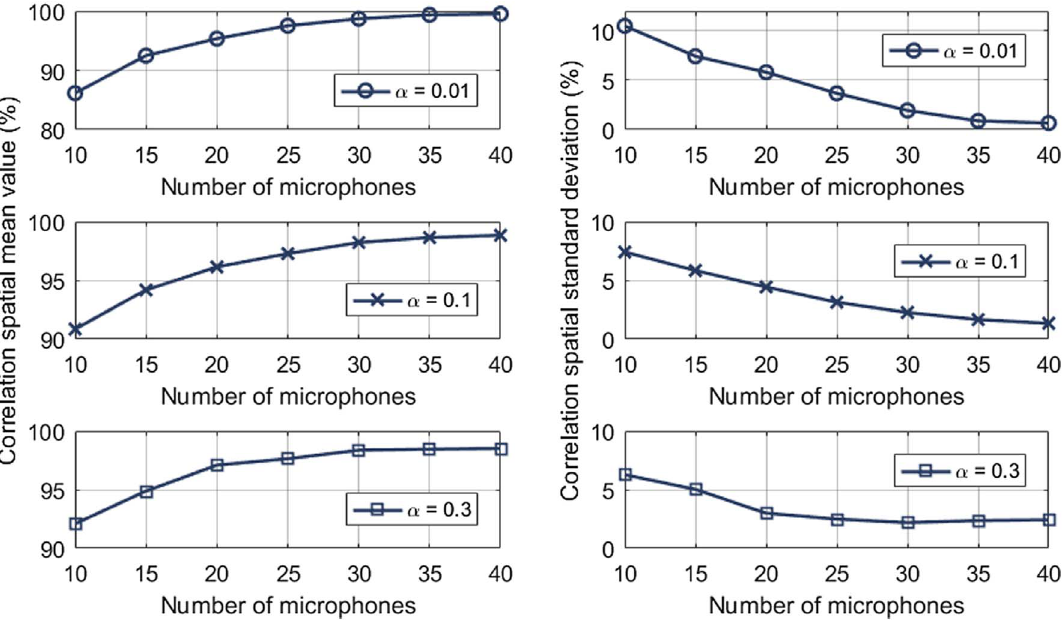
Figure 9. Analysis of the Pearson Correlation of the reconstructed sound fi eld with respect to the number of measurement